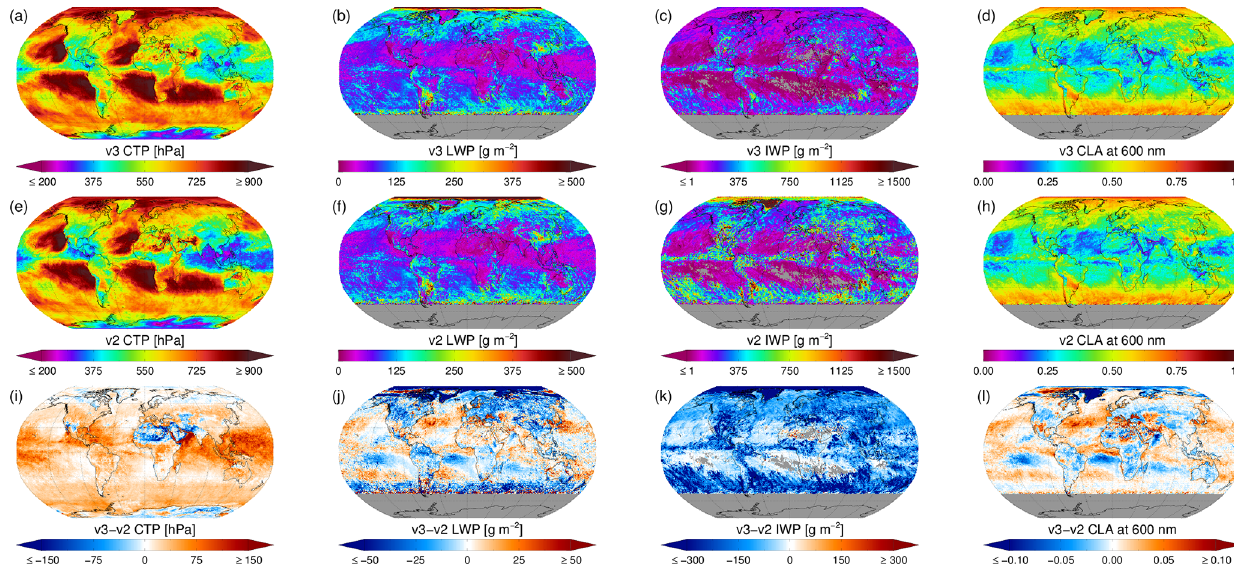
Figure 2. As in Fig. 1 but for CTP, LWP, IWP and CLA.